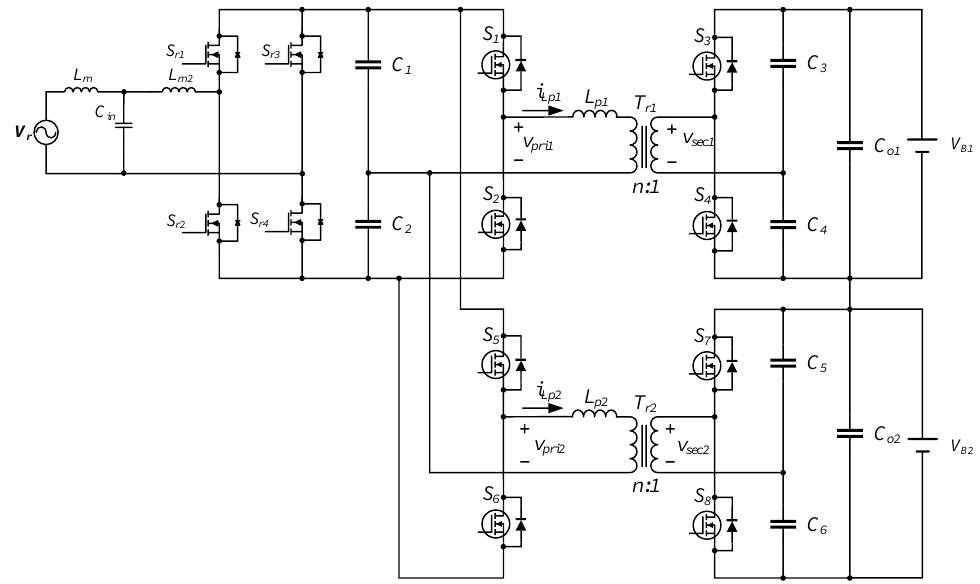
Figure 3. Circuit diagram for the proposed bidirectional DC – AC converter.